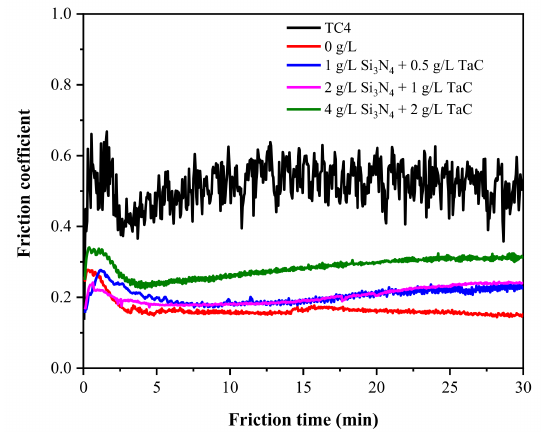
Figure 6. Friction coefficient of both the TC4 alloy and the composite MAO coatings with different concentration of Si 3 N 4 /TaC particles.